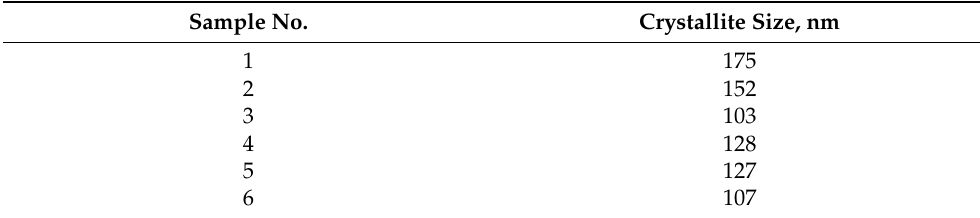
Table 2. The values of W crystallite sizes obtained by the Williamson–Hall approach. Sample No.